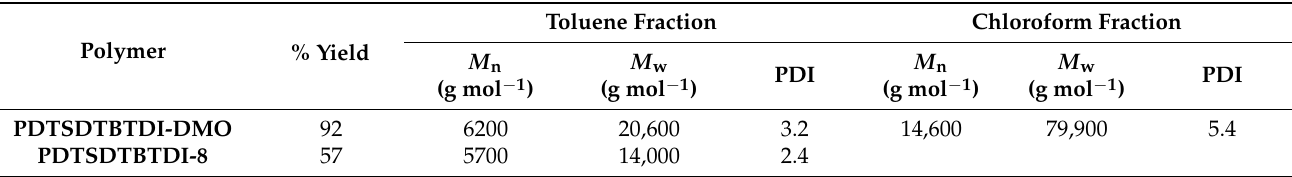
Table 1. The percentage of production, weight and number average molecular weights with polydispersity indexes of PDTSDTBTDI-DMO and